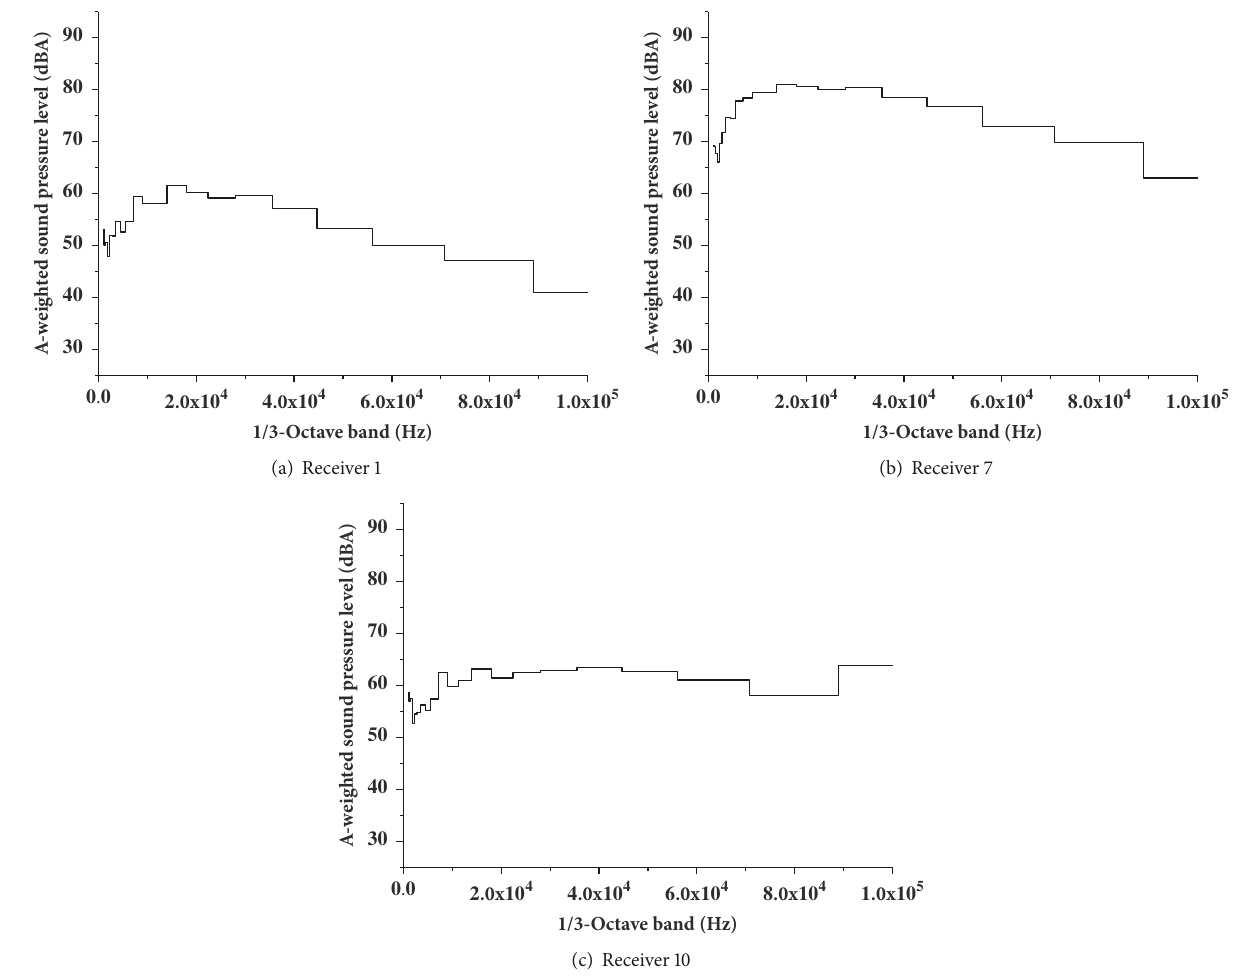
Figure 12: Sound pressure level distribution of typical receivers under scheme